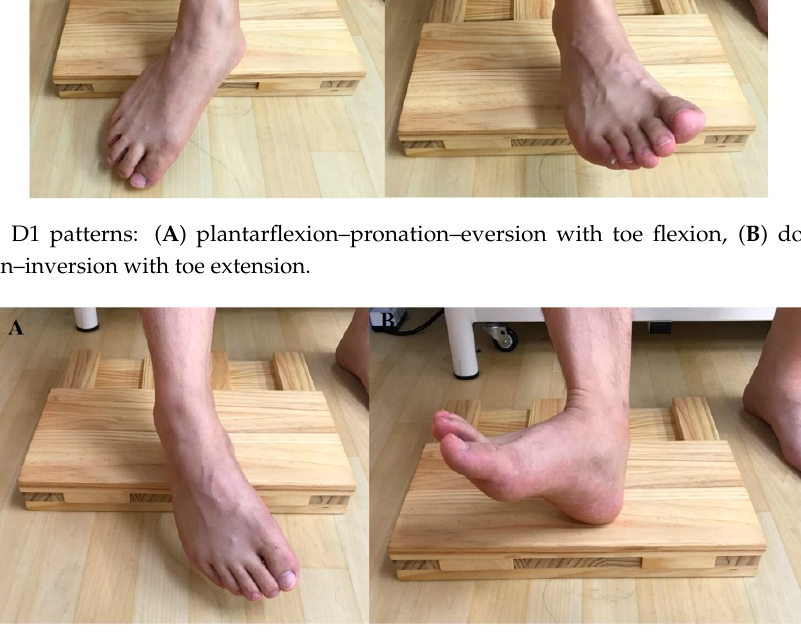
Figure 6. D2 patterns: ( A ) plantarflexion–supination–inversion with toe flexion, ( B ) dorsiflexion–pronation–eversion with toe extension.